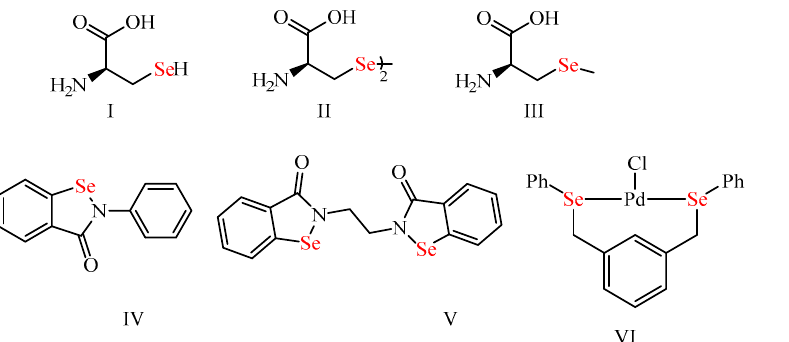
Figure 1. Organoselenium compounds ( I – VI ) with potential biological activities and diverse appli- cations.